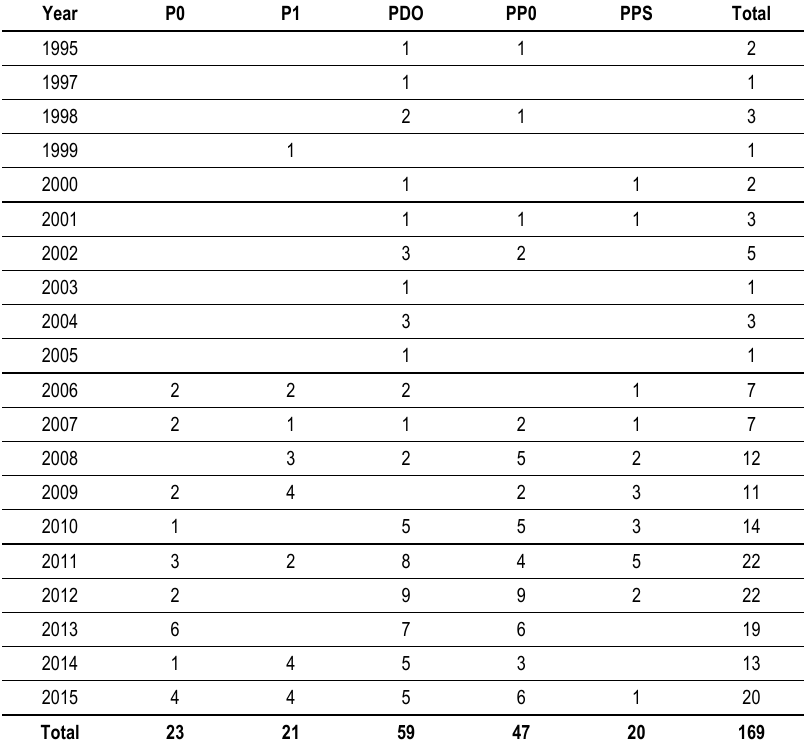
Table 6. Finding results according to the Three Phase Front End